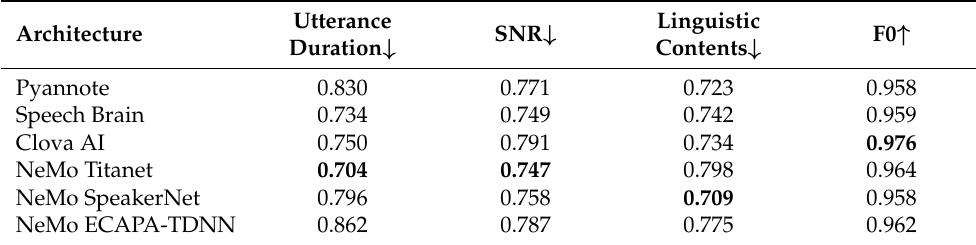
Table 5. LightGBM-based SRCC results for various regression tasks. Arrows mark the direction of best performance. Best results are highlighted in